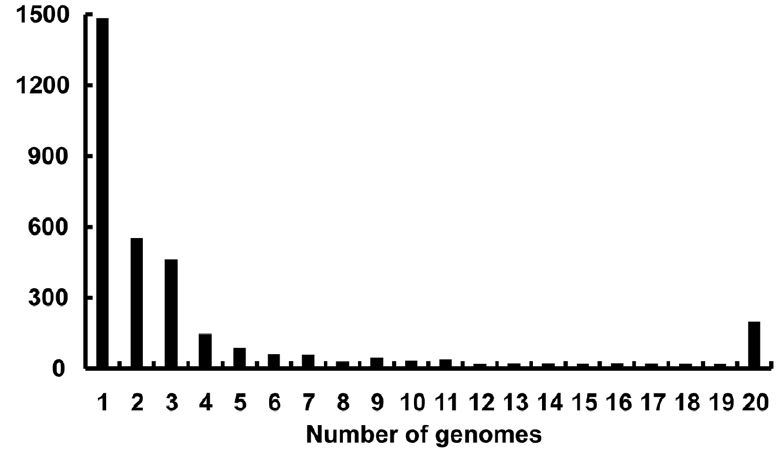
Figure 2. Frequency of genes within the 20 genomes included in this analysis. Genes present in a single genome represent lineage specific genes, while at the opposite end of the scale, genes found in all 20 genomes represent the Mycoplasma core genome.